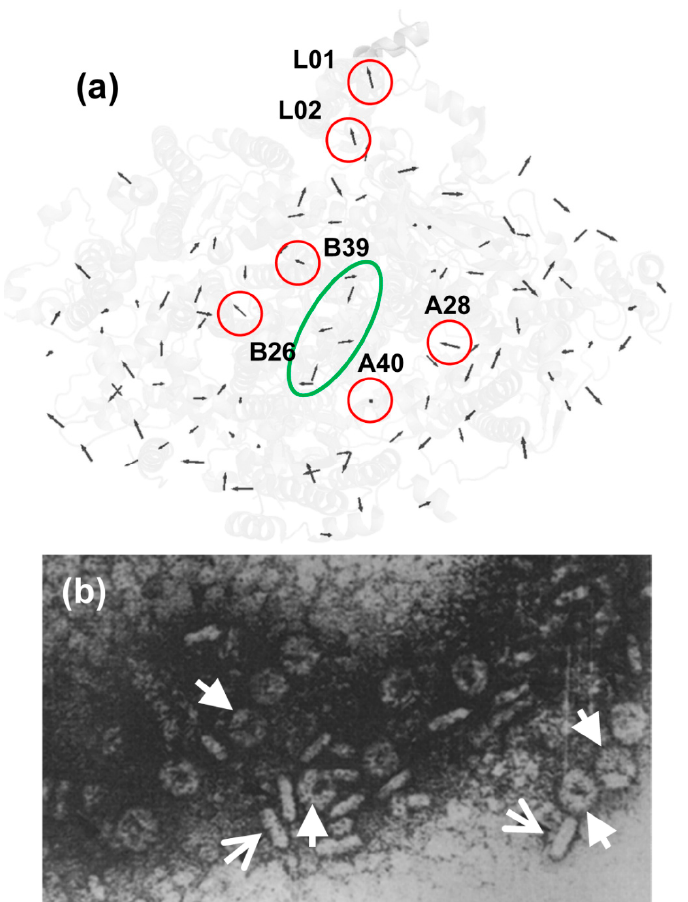
Figure 9. The Qy transition moments of Chl in the proposed monomer model for PSI isolated from Arthrospira platensis are shown ( a ). The Qy transitions of the assumed red Chls are marked with red circles. The green ellipse marks the reaction center. Micrograph of PSI trimers form Arthrospira platensis ( b ) taken from the literature [21] . The arrows indicate the top and side views of the trimers.